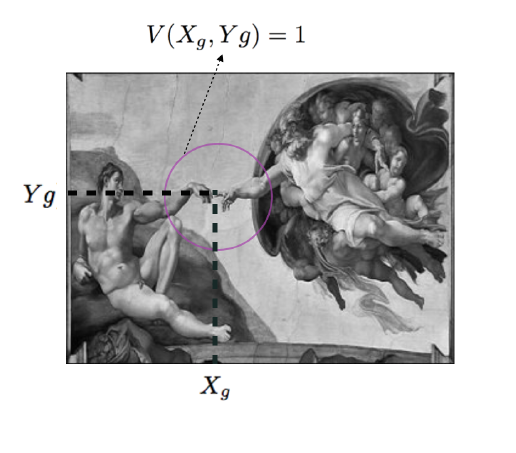
Figure 14: The image represents the position of the goal and the winner emotional value, where positive emotional value = 1, and negative emotional value = 0.